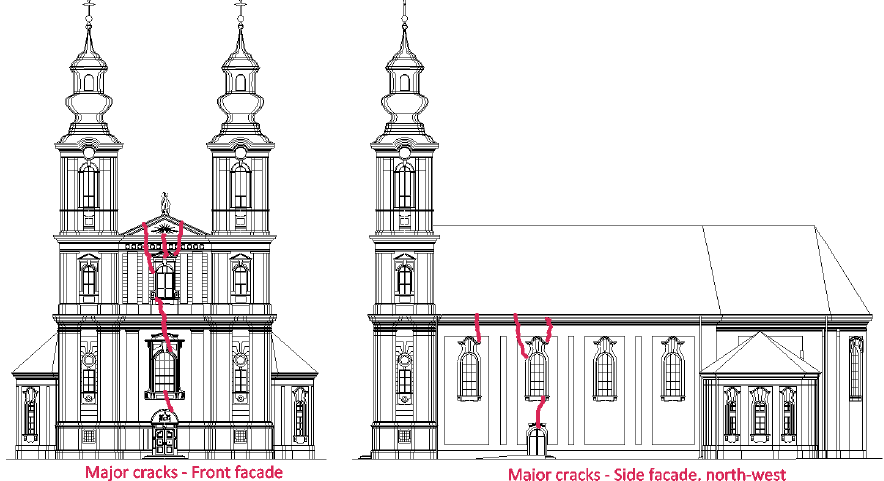
Figure 4. Crack monitoring gauges within the Cathedral—inner side of the front facade wall.